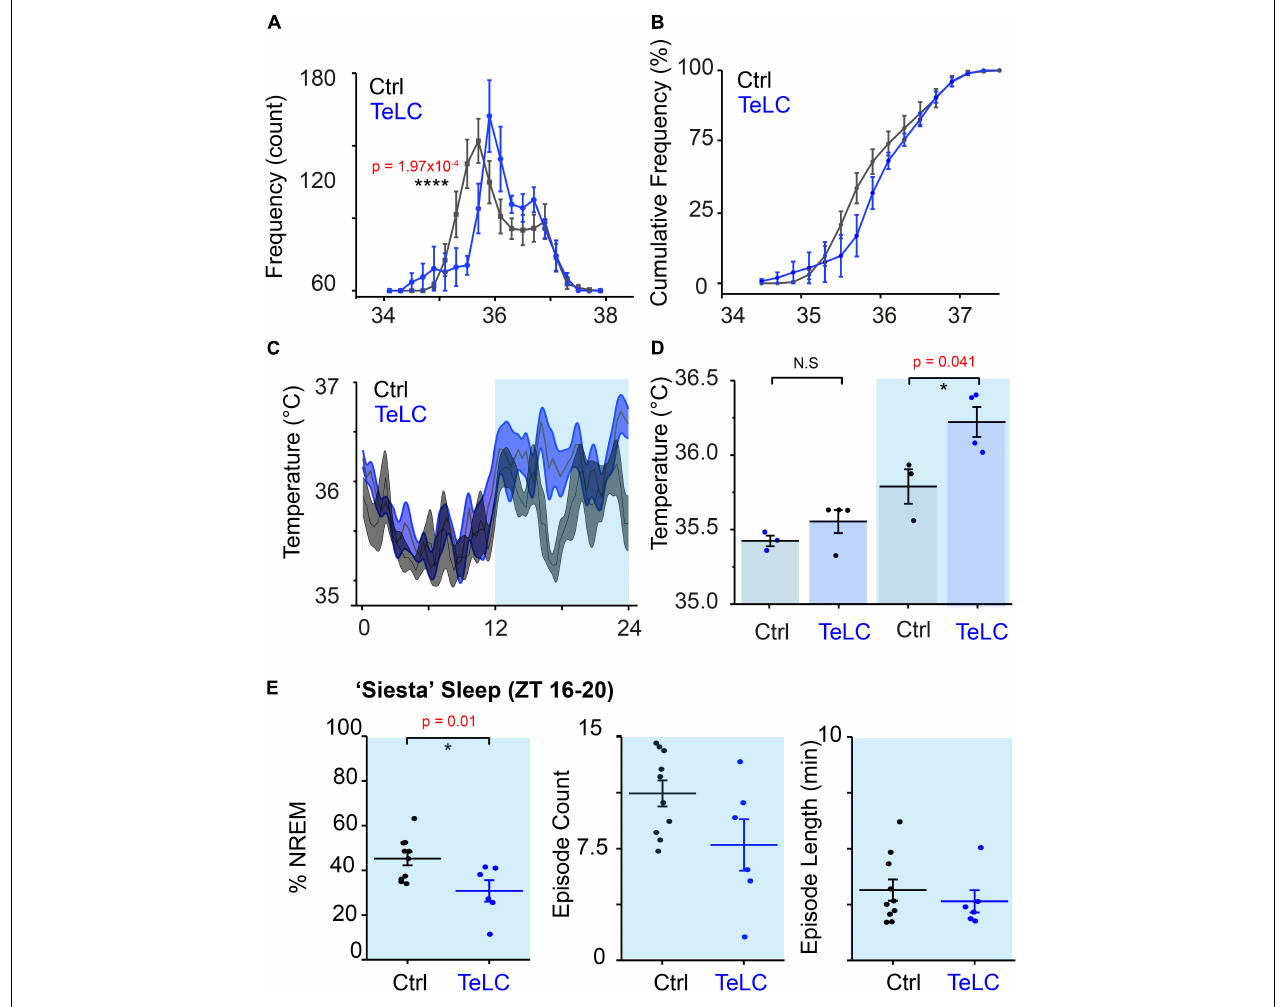
FIGURE 6 | NOS1 neurons in MnPO/MPO hypothalamus act to reduce body temperature. (A) Aggregated temperature data from 7 days of recording for each mouse averaged by ZT time at 2-min intervals to produce a ‘typical’ day histogram, averaged for each group (rmANOVA, n = 4, TeLC; n = 6, GFP; temperature × group at 35.4–35.6 ◦ C, p = 1.97 × 10 − 4 ). (B) Cumulative frequency of temperature distribution. (C) Temperature profile over 24 h. (D) Quantification of 24-h temperature profile in the light and dark phase (two-tailed t test assuming unequal variance, n = 4, TeLC; n = 3, GFP; p = 0.041). (E) Percentage sleep